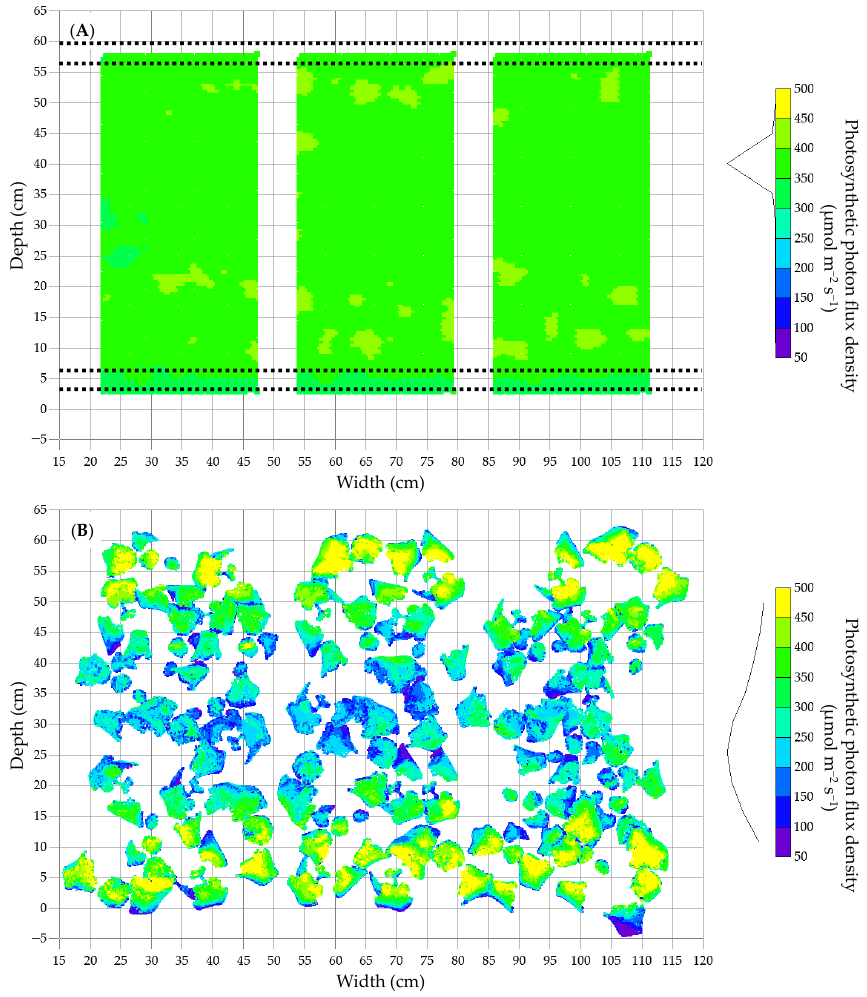
Figure 10. PPFD distributions across the growing surfaces ( A ) and canola leaves ( B ) with the same lighting design conditions. The distance between the growing surface and lamps was 21.9 cm, and the average distance between the canola canopy and lamps was approximately 14 cm. The color bars indicate the PPFD values and the lines to the left of the color bars are the frequency distribution curves. The dotted lines in ( A ) indicate the positions of the BRLED lamps.